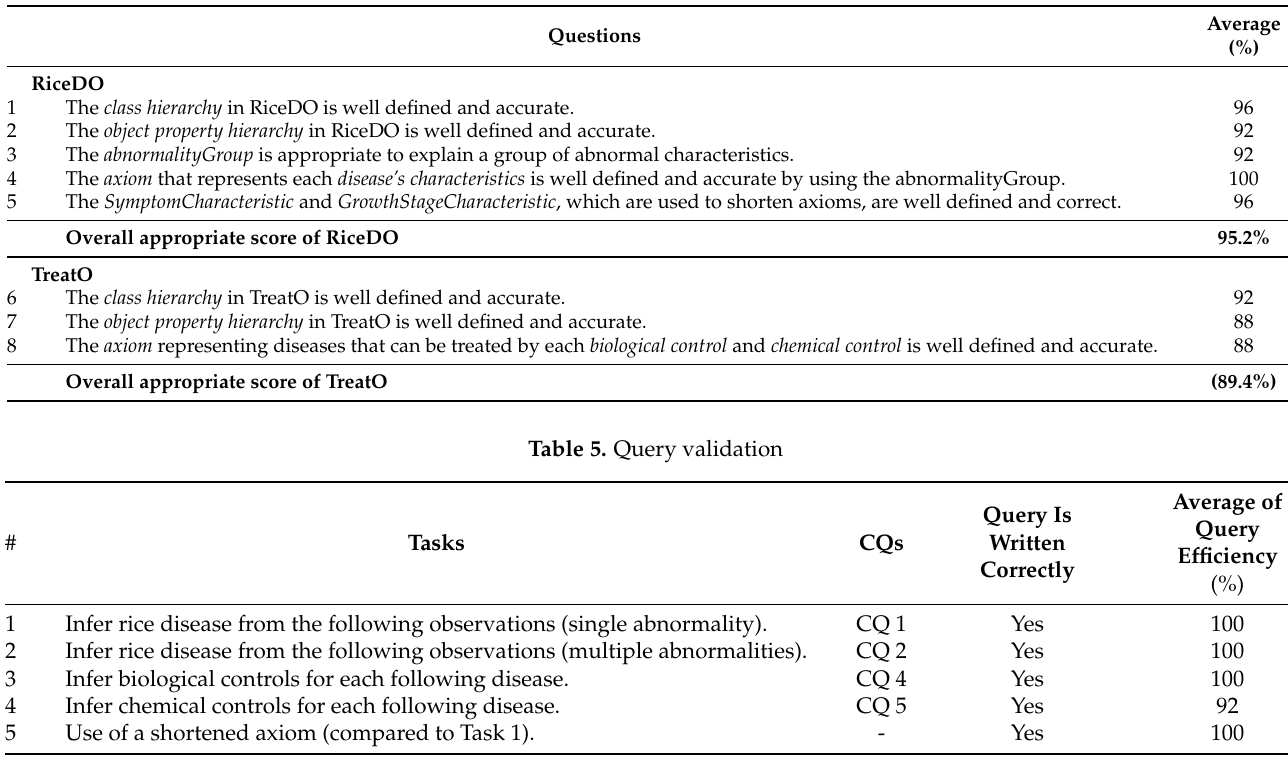
Table 4. Verifying the appropriateness of RiceDO and TreatO ontologies